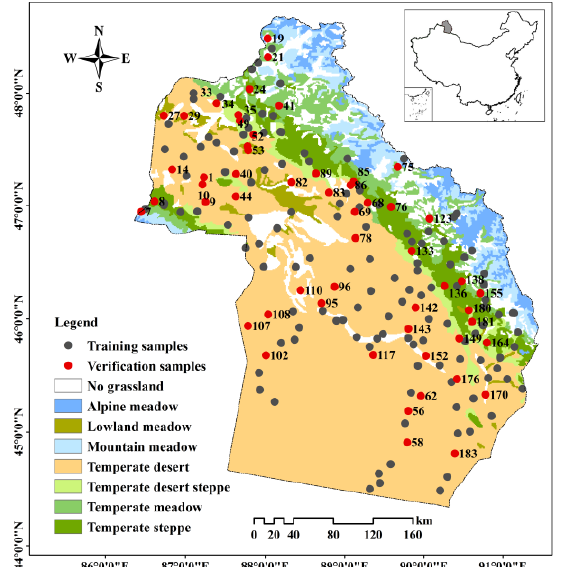
Figure 1. Sampling locations and grassland types in Altay Prefecture, China.